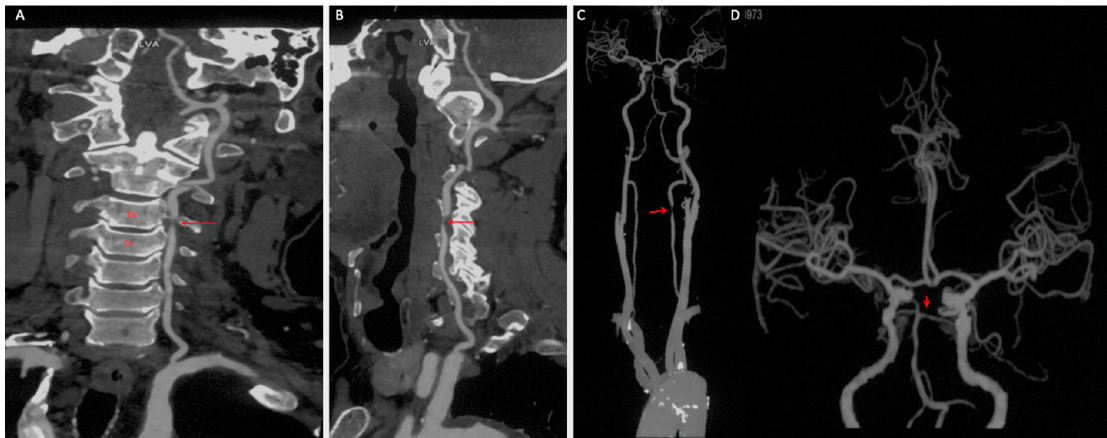
Figure 1. Target vertebral artery anatomy before endovascular intervention. ( A , B ) Computed tomography angiography of the left V2 segment before intervention. Dominant left vertebral artery V2 segment severe stenosis (( A – C ), red arrow) and an undeveloped left posterior cerebral artery, together with incomplete circle of Willis, are shown (( D ), red arrow).